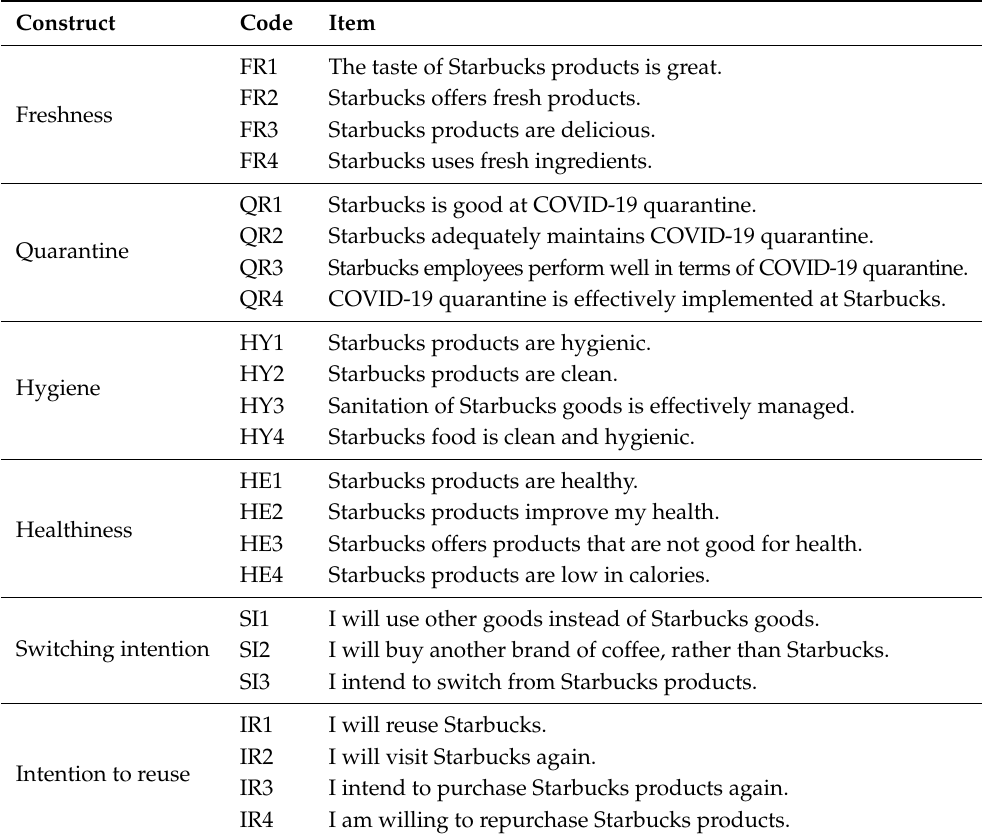
Table 1. Measurement